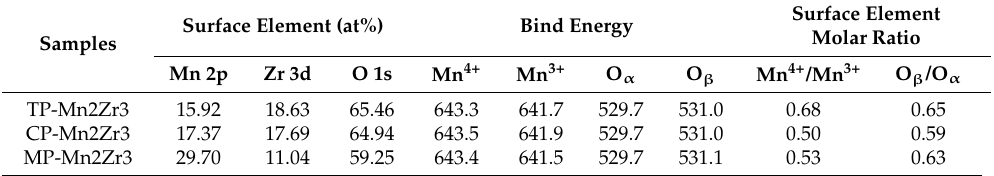
Figure 4. XPS spectra of ( a ) full spectra, ( b ) Mn 2p, ( c ) O 1s, ( d ) Zr 3d over TP, CP, and MP-Mn2Zr3.